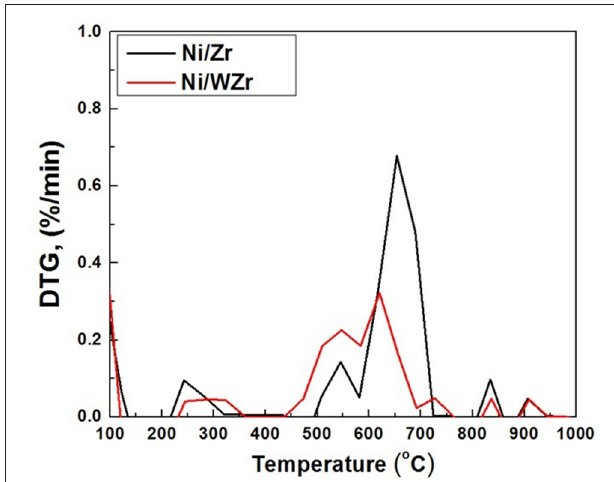
FIGURE 6 | DTG graphs of the spent